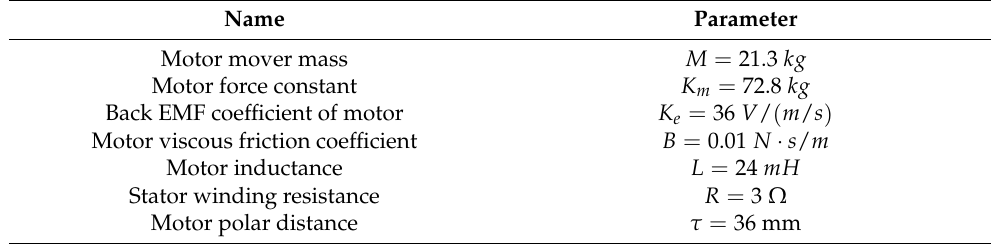
Table 2. Parameter table of X-shaft linear